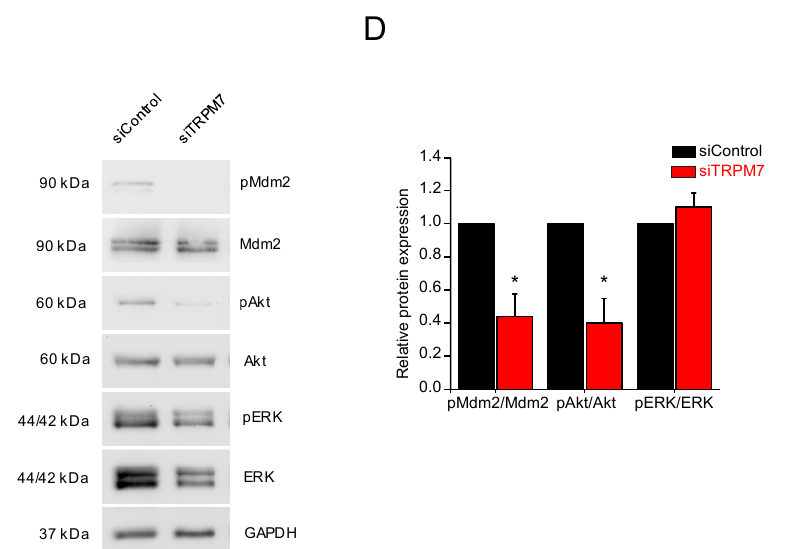
Figure 4. TRPM7 is able to regulate PS-1 proliferation through the PI3K/Akt pathway. ( A ) Cell